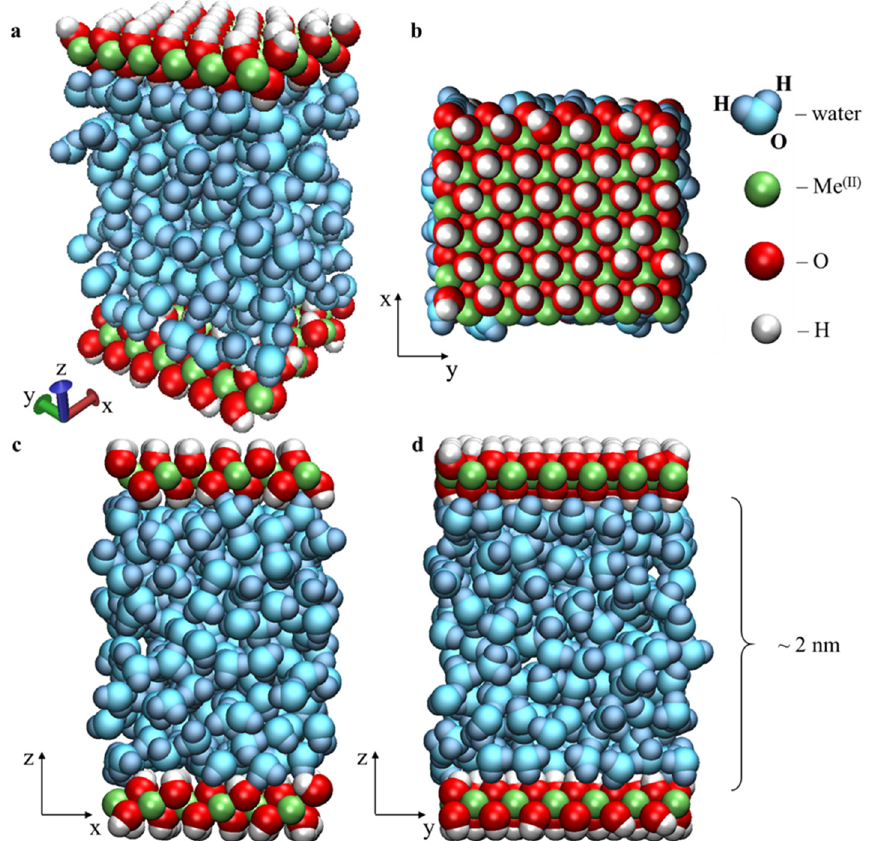
Figure 1. Initial configuration of the modelled system’s periodic boxes 36[2Me (II) (OH) 2 ·7H 2 O] equilibrated at the pressure 0.1 GPa: perspective view ( a ), top view ( b ), x–z view ( c ), and y–z views ( d ).